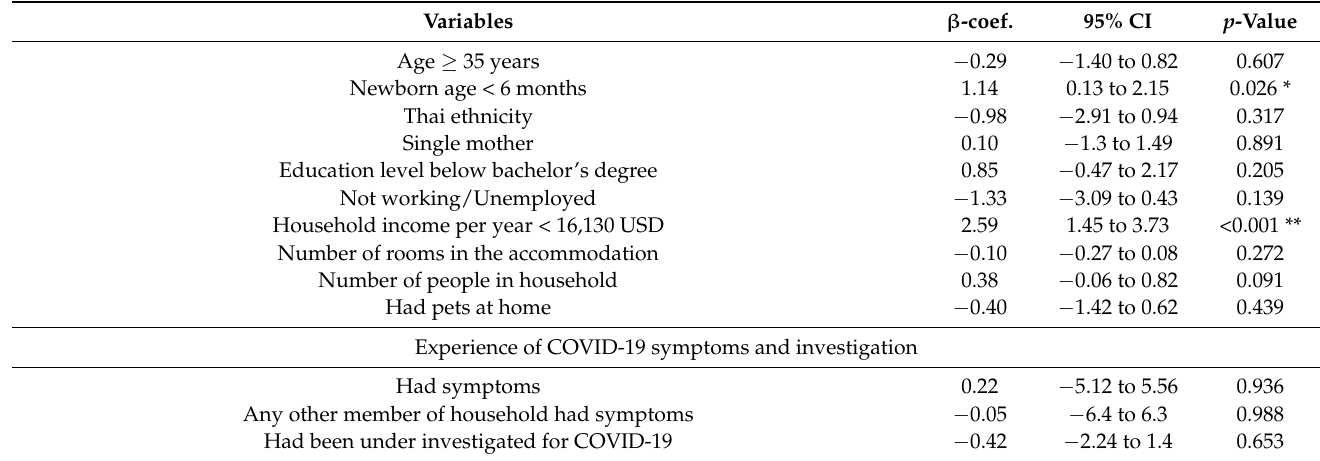
Figure 4. Relationship identification of maternal mental health during the COVID-19 nationwide lockdown period. Green ovals, yellow ovals, and pink ovals represent significant, not significant associated factors, and confounders, respectively. Green arrows indicate significant positive associations, whereas red arrows represent significant negative associations. Black arrows represent the direction of associations, which are not significant paths or confounding paths. The directed acyclic graphs were generated with publication licensed by BioRender, Toronto, Canada (Agreement number: QG237SORHP, 19 November 2021). Table 4. Association between socio-demographics, perception of COVID-19 lockdown impacts, maternal activities, illness experience, and maternal mental